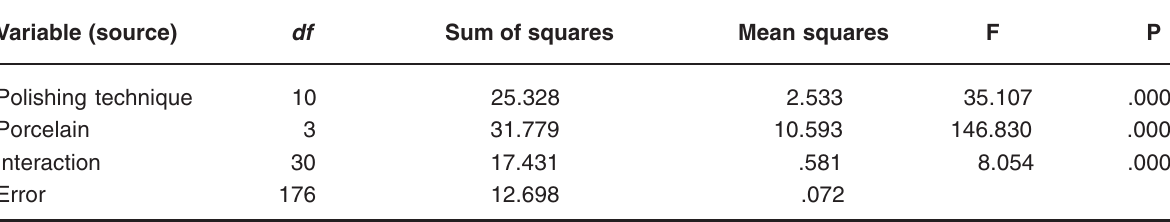
*Significant difference at p<.05.